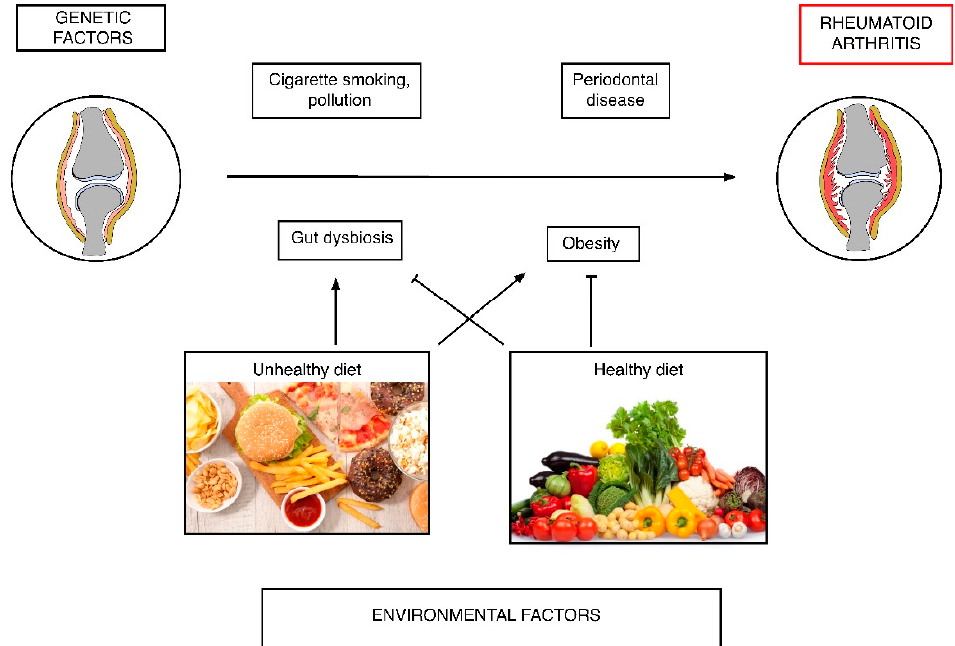
Figure 1. Role of diet in rheumatoid arthritis (RA) Figure 1 : Role of diet in rheumatoid arthritis (RA) pathogenesis